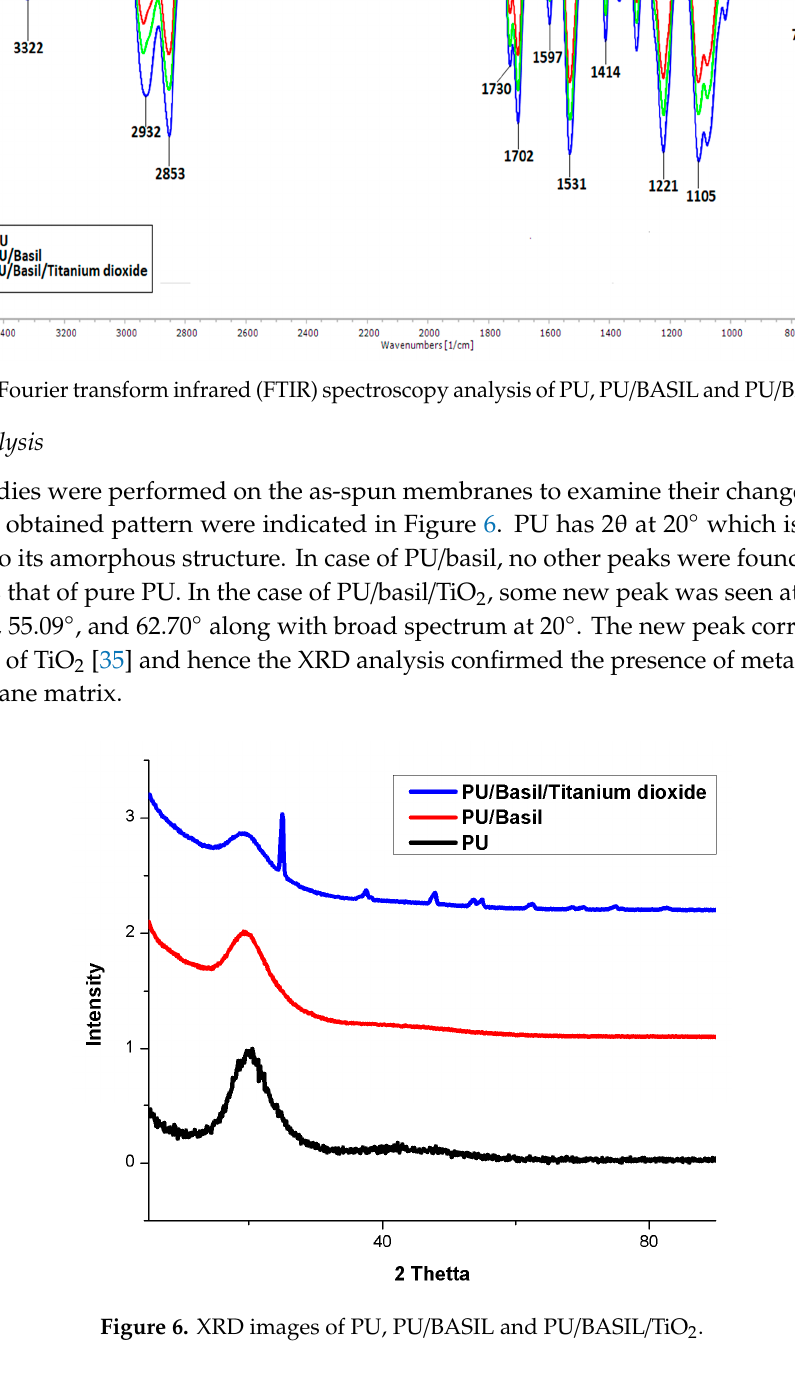
Figure 6. XRD images of PU, PU/BASIL and PU/BASIL/TiO 2 .